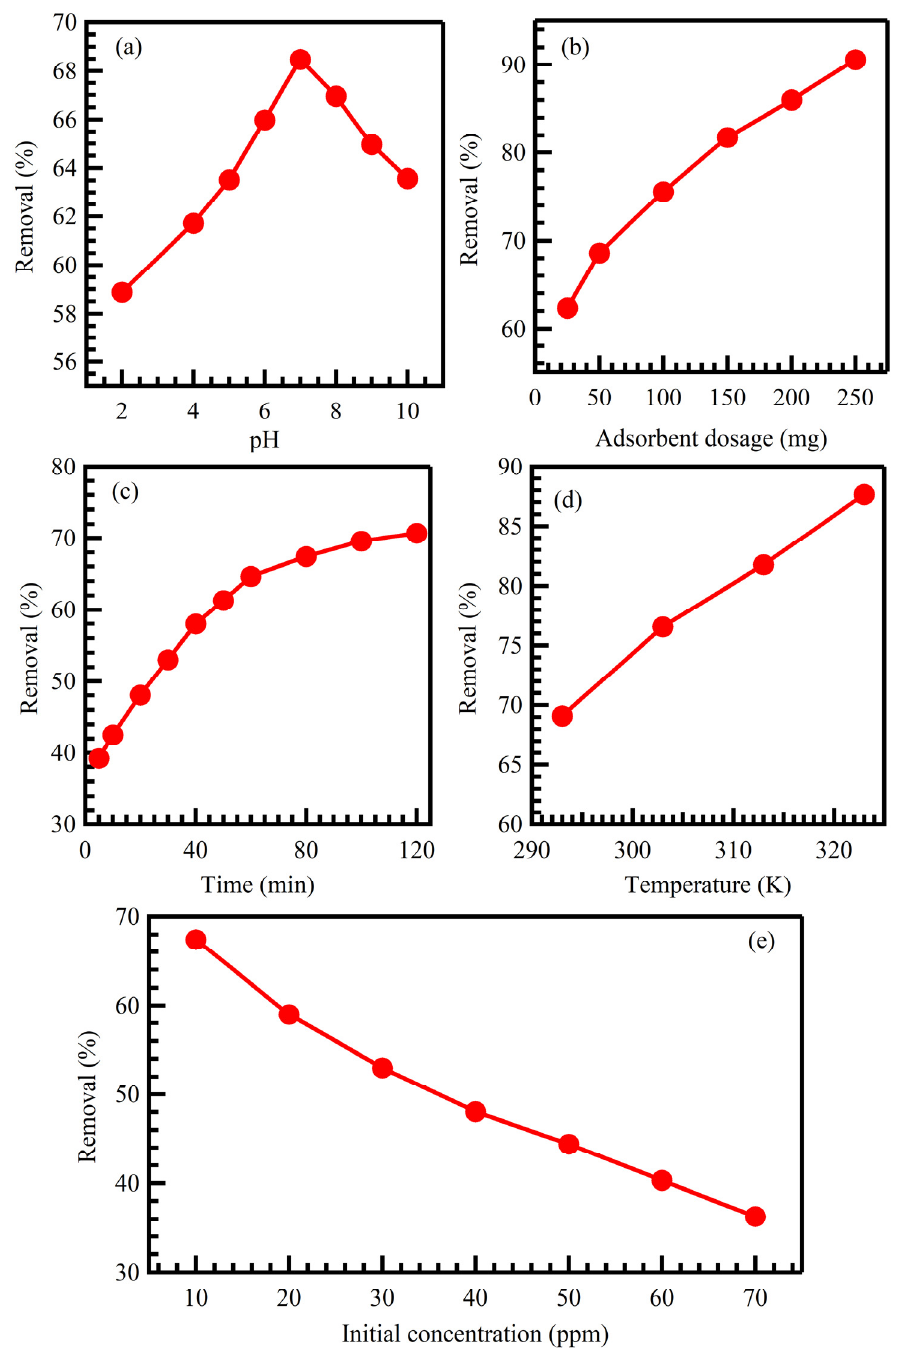
Figure 4. Effects of the solution pH ( a ), HAP mass ( b ), time ( c ), temperature ( d ), and initial concen- tration ( e ) on the adsorption percentage of Ceph from aqueous solutions onto HAP. The mass effect of HAP on Ceph adsorption from a 10 mg/L aqueous solution is shown in Figure 4b. It shows that the percentage that was removed from the aqueous solution was increased from 62.3 to 90.6% as the HAP dose increased from 25 to 250 mg. The contact time between the adsorbent and adsorbate is a key factor in removing any pollutants from the environment through adsorption. The effects of contact time on removing Ceph by HAP were investigated, and the results are illustrated in Figure 4c. The figure shows that the increase in contact time increased in the adsorption process. This effect was particularly observed during the first 60 min, where the majority of the Ceph